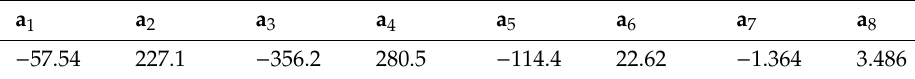
Figure 4. Errors between the real OCV and the calculated OCV. Table 2. Data of the open-circuit voltage and State of Charge curve.